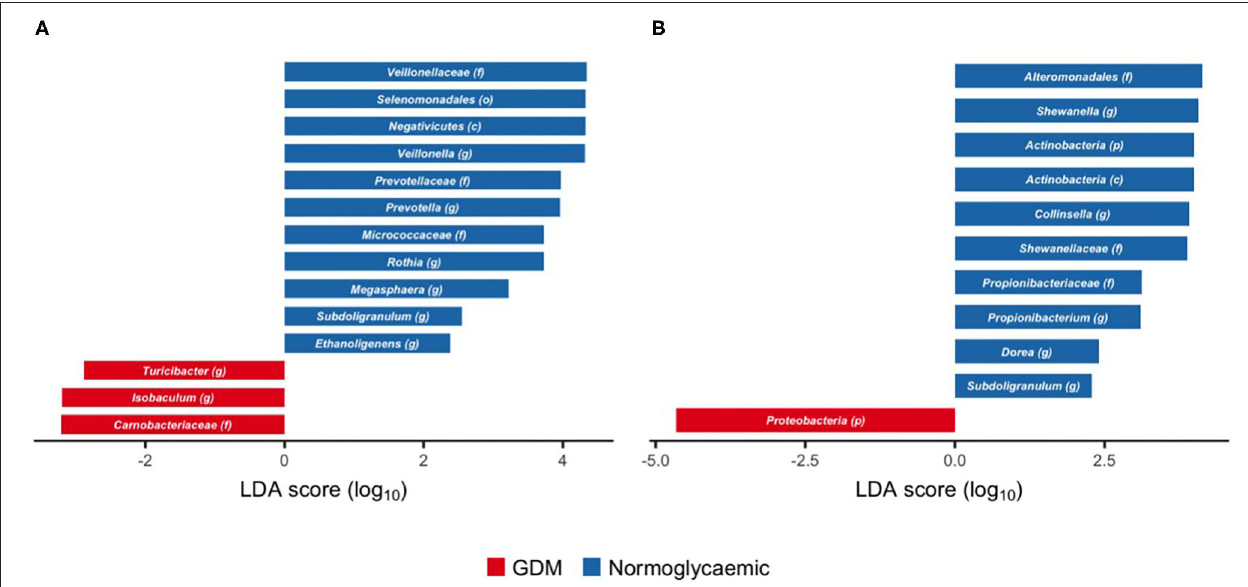
FIGURE 4 | Taxonomic biomarkers of gestational diabetes in gut microbiota of newborns and infants. Scores of taxonomic biomarkers of gestational diabetes in newborns (1 week of life) (A) and infants (at an average of 8.8 months of life) (B) to genus level identified by linear discriminant analysis (LDA) using LEfSe. Color indicates the group in which a differentially abundant taxon is enriched. (p) phylum, (c) class, (o) order, (f) family, (g)